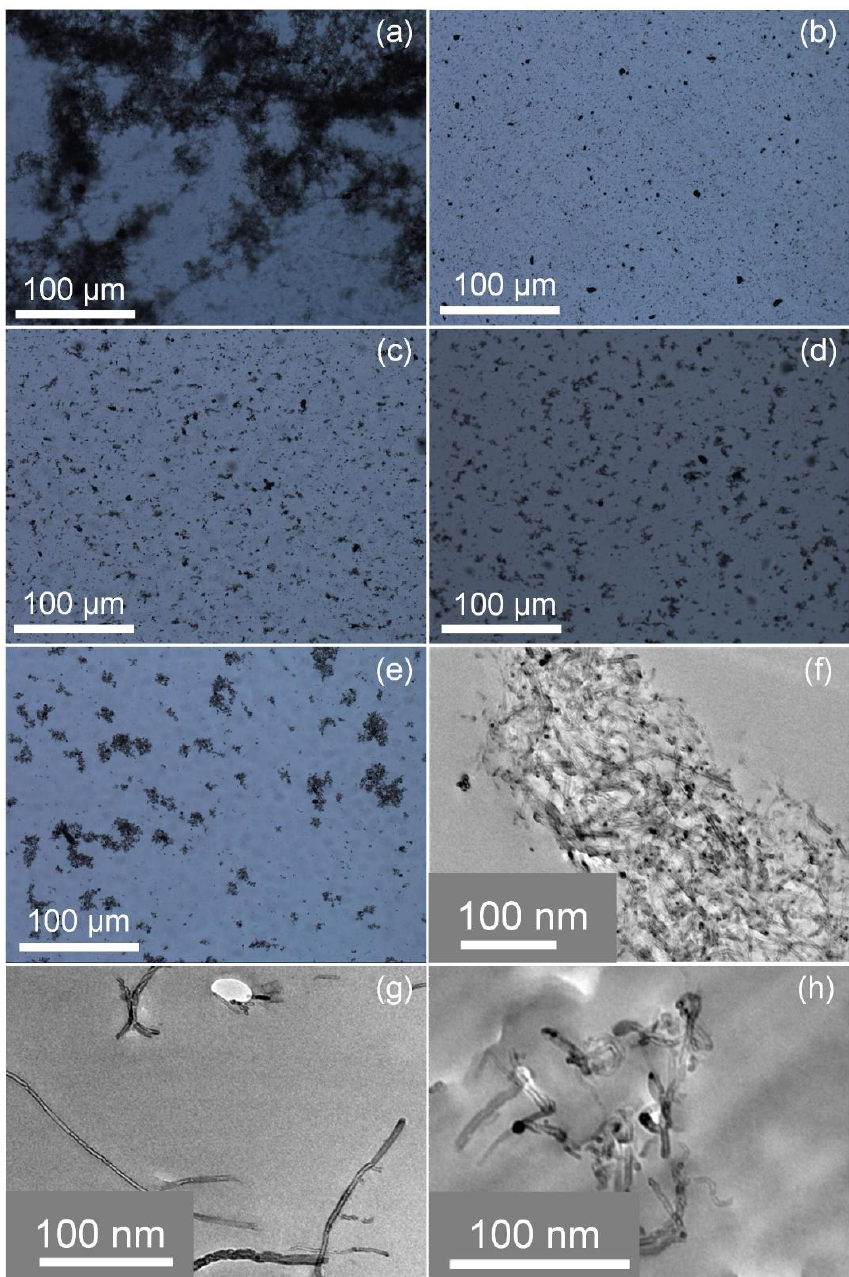
Figure 4. TOM images of the epoxy nanocomposites with 0.05 wt% ( a ) p-MWNTs, ( b ) B1@ f